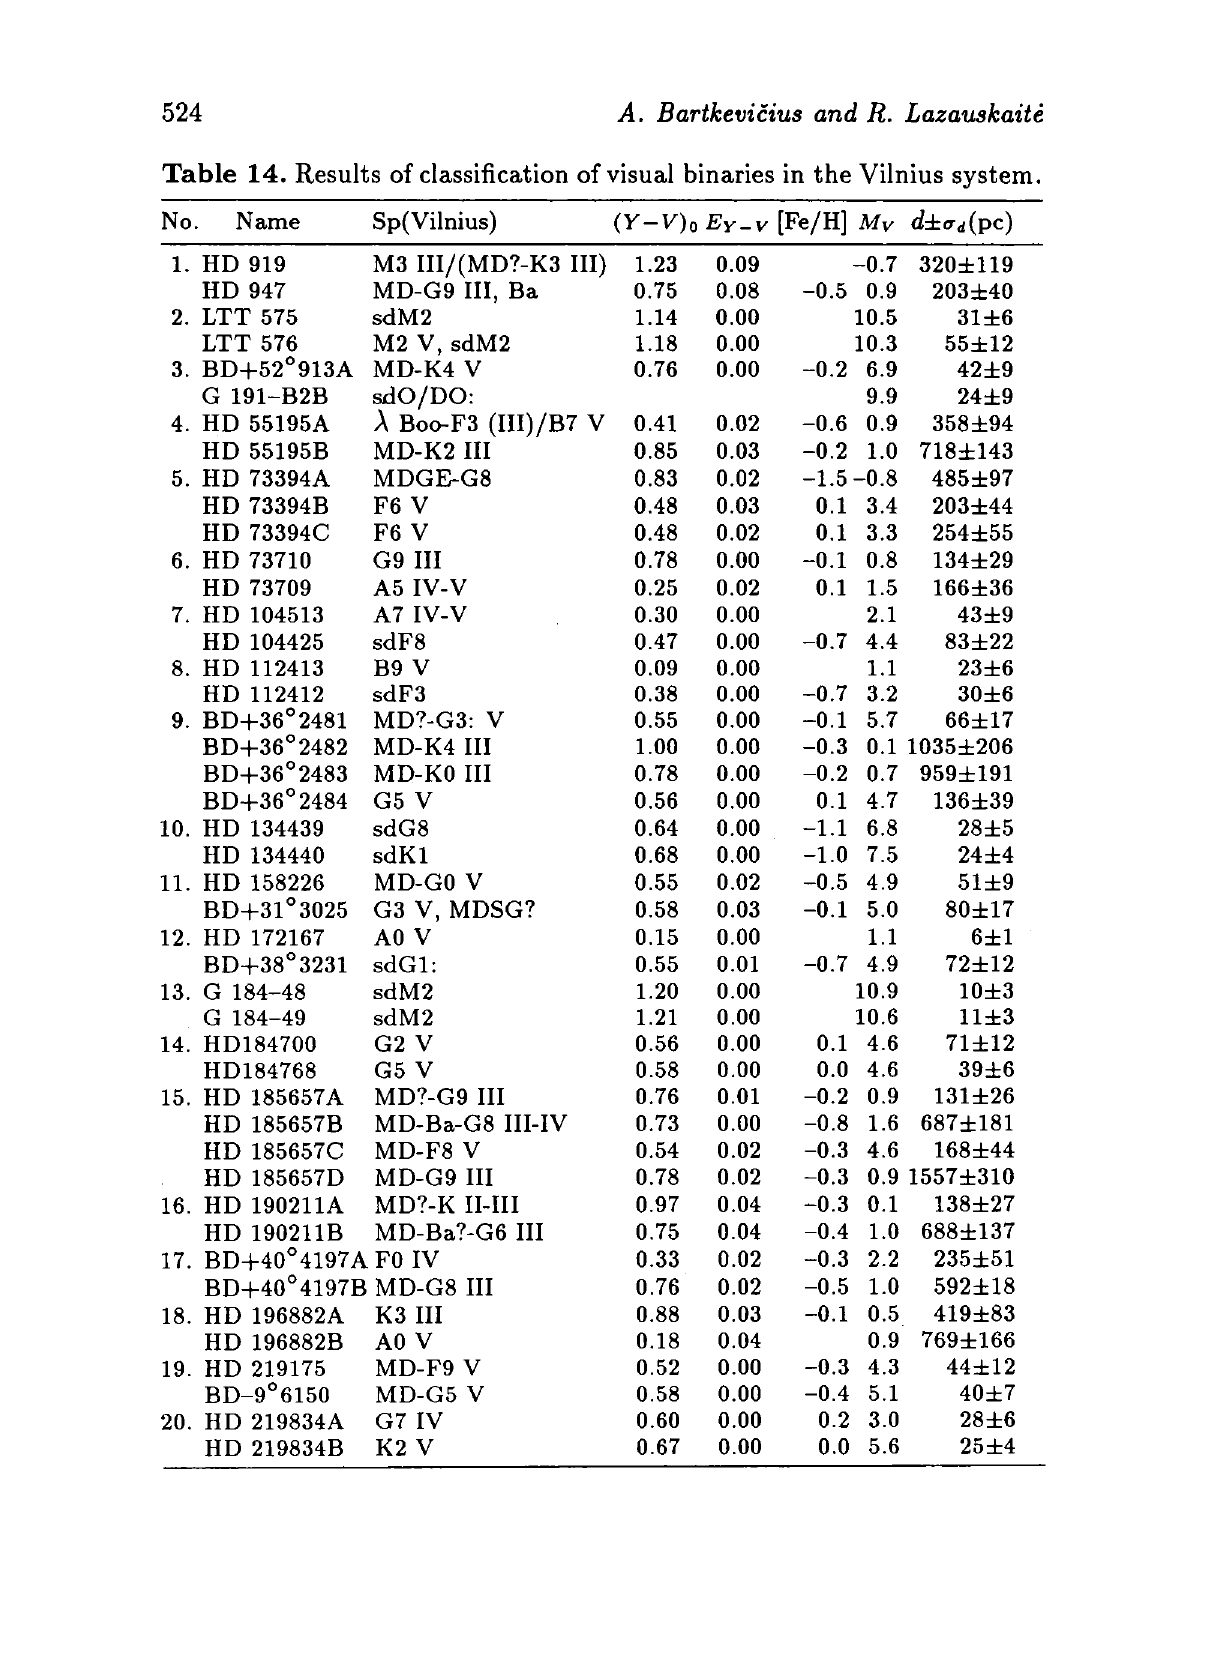
Table 14. Results of classification of visual binaries in the Vilnius system.